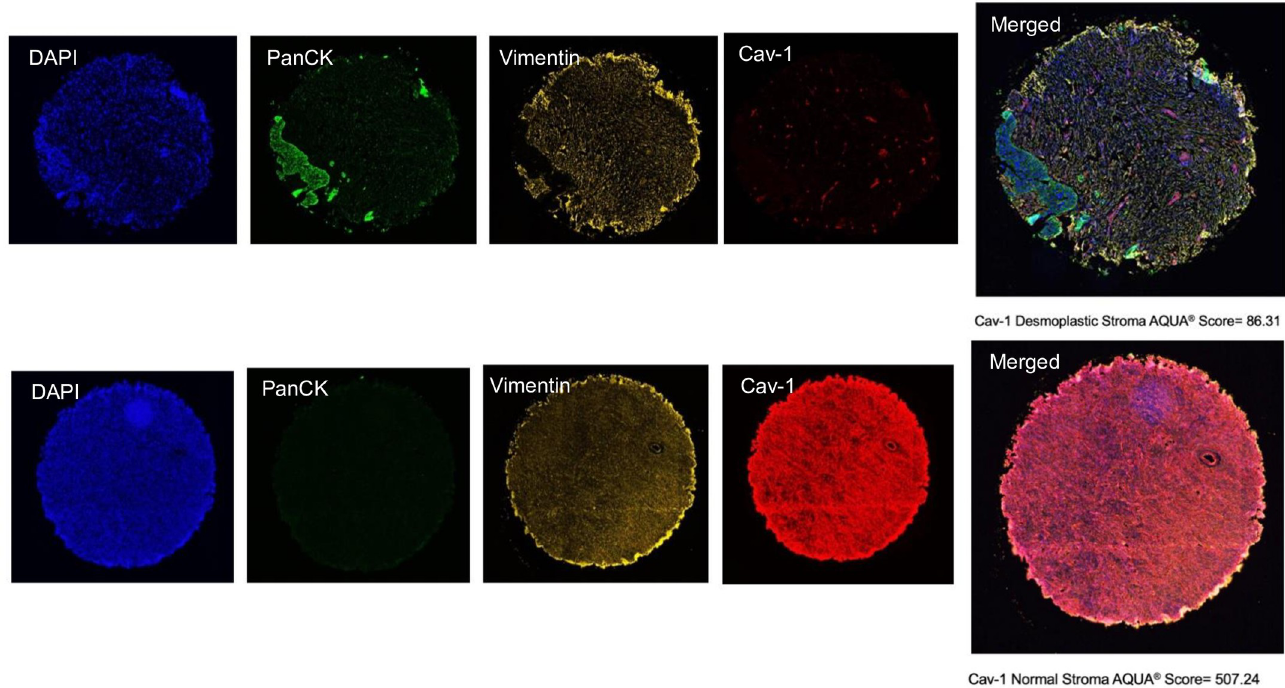
Fig 3. Multiplex immunofluorescent staining of ovarian tissues in Cohort 2. Representative staining for high-grade ovarian serous adenocarcinoma (top) and benign ovarian tissue (bottom) are provided. Compartmental regions were identified based on DAPI, PanCK, and DAPI staining. Tumor (desmoplastic) stroma regions comprised stromal cells (Vimentin+) with a nucleus (DAPI+), and not epithelial